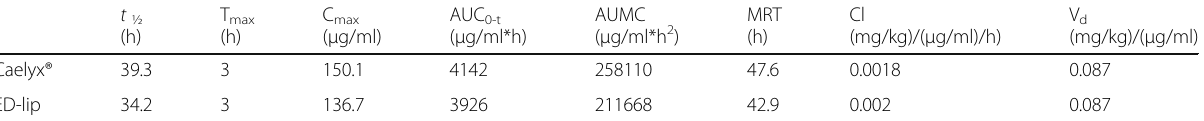
Table 3 Non-compartmental model of pharmacokinetic parameters of Caelyx® and ED-lip administrated i.v. in mice at the single dose of 10 mg/kg